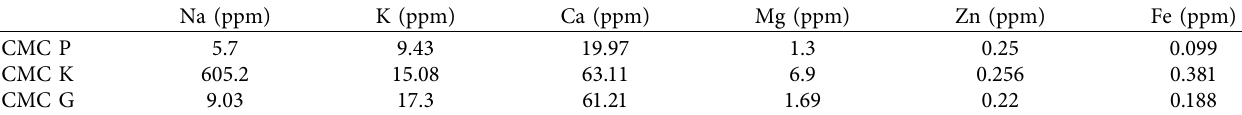
Table 4: Mineral composition of camel cheese with different enzymatic extracts.